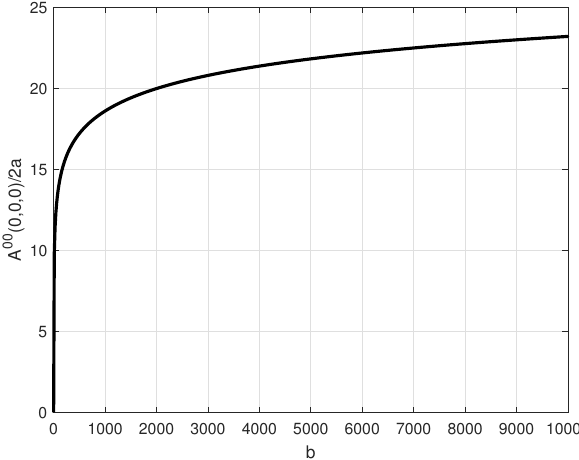
Figure 2. A demonstration that the magnitude of the three-dimensional potential A 00 (Equation (2)) grows without bound as the dimension b of the loaded rectangular region R becomes large. Thus Equations (17) and (18) are not well defined for constant surface